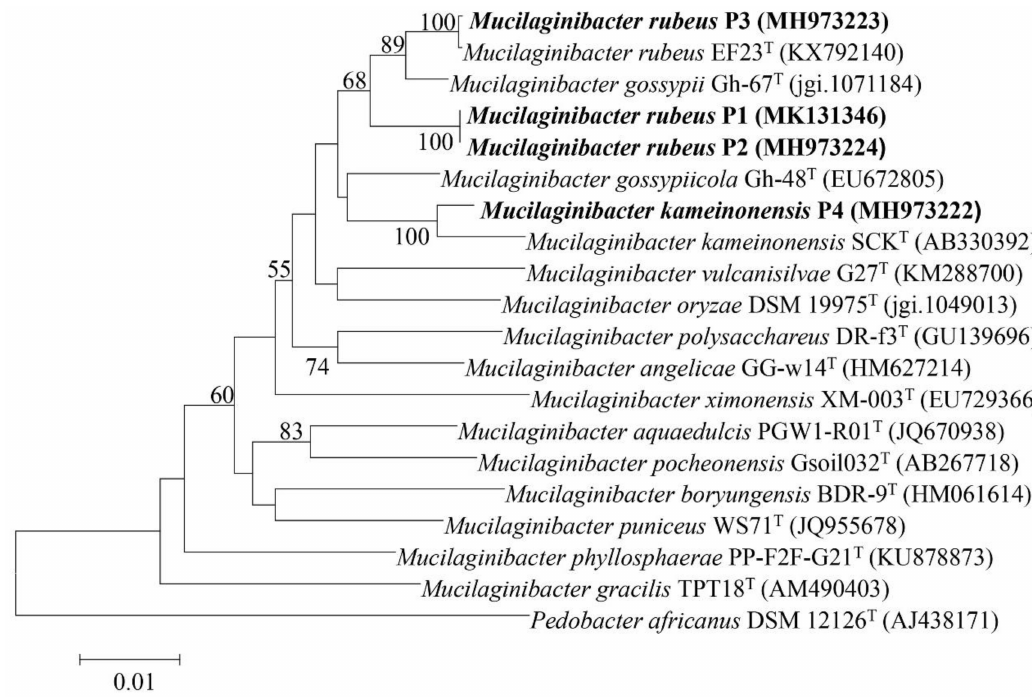
Figure 1. Neighbour-joining phylogenetic tree constructed based on the 16S ribosomal RNA (rRNA) gene sequences from the draft genome sequence showing the phylogenetic relationships between strains Mucilaginibacter rubeus P1, P2 and P3 and Mucilaginibacter kameinonensis P4 and other species in the genus Mucilaginibacter . Values indicate percentages of identical branching in 1000 bootstrappings. The sequence of Pedobacter koreensis WPCB189T was used as an out-group. Bar, 0.01 substitutions per nucleotide